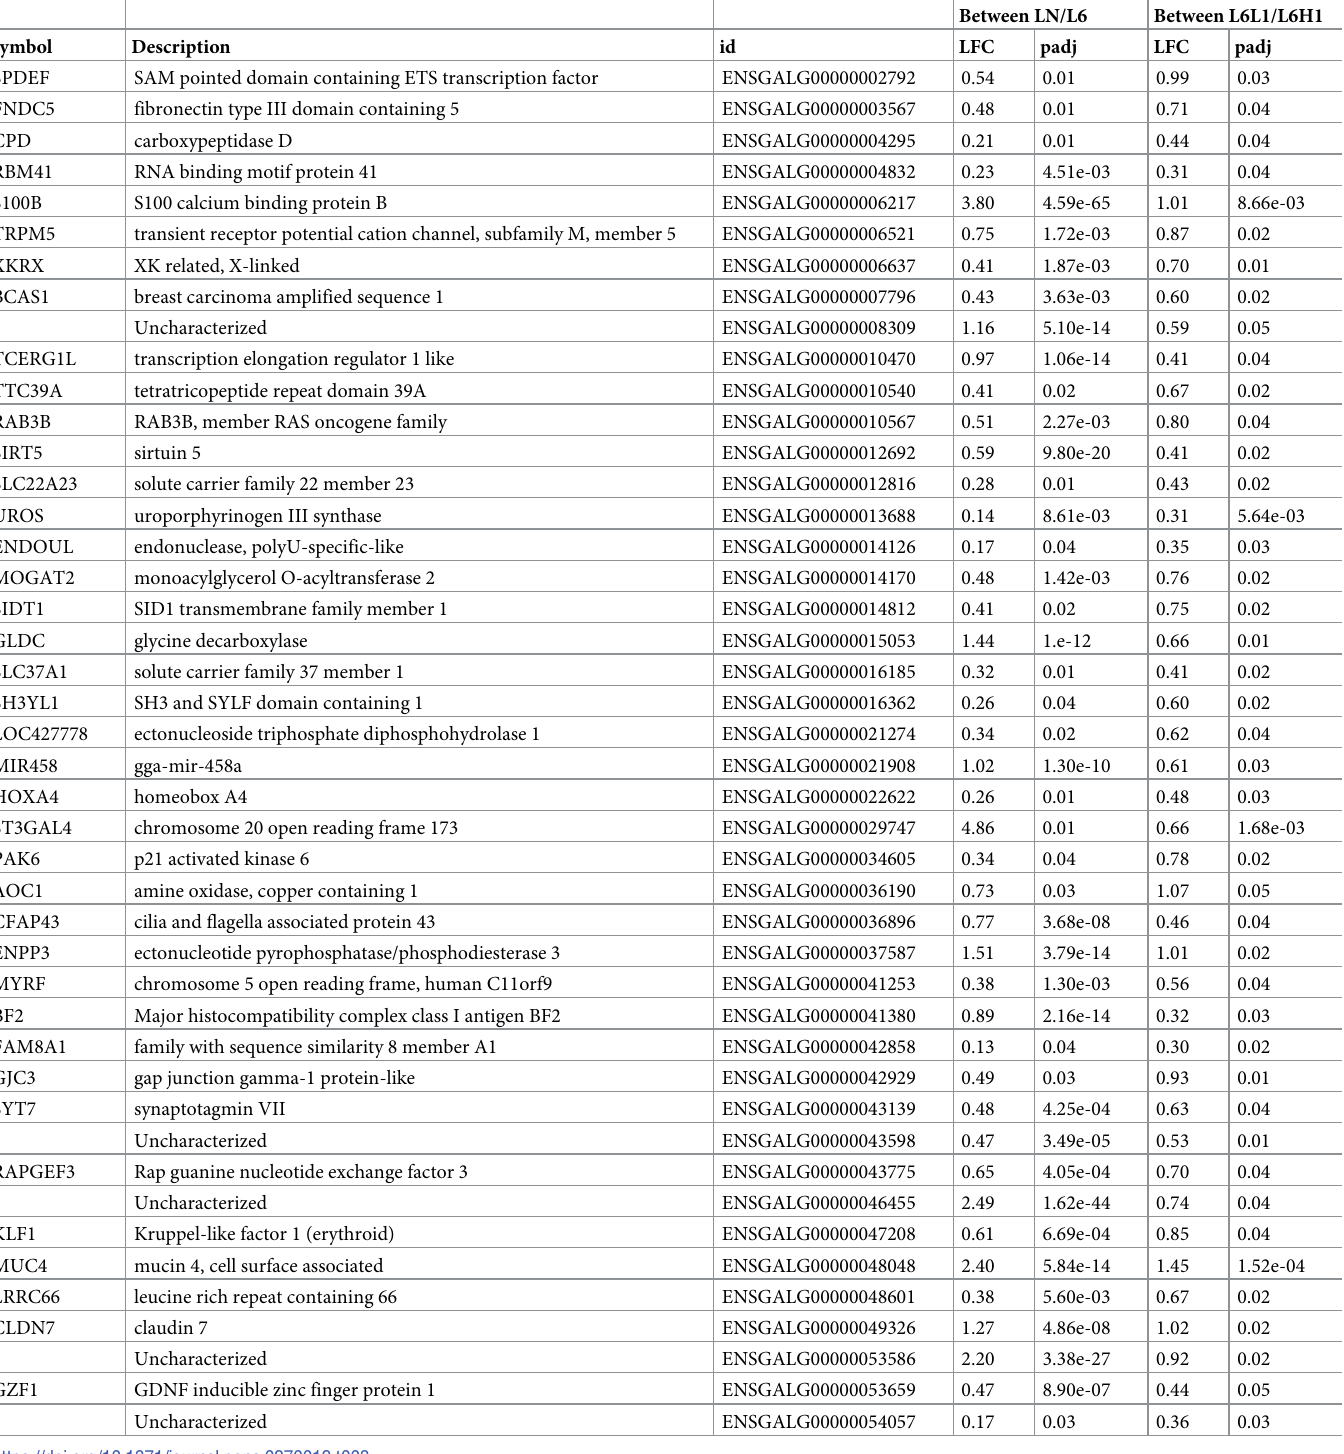
Table 3. Common differentially expressed genes downregulated between LN/L6 analysis and LNL1/LNH1 analysis (potentially associated with resistance to Salmonella